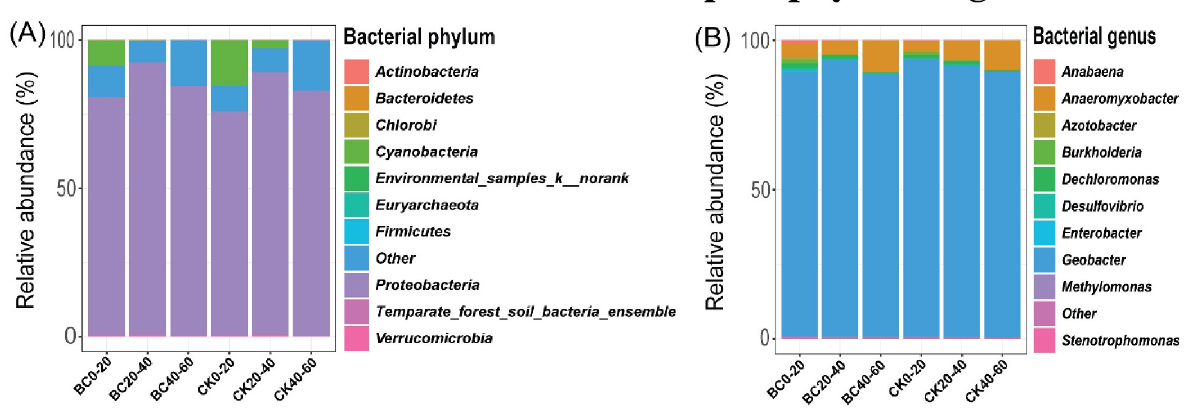
Fig 4. Diazotrophic bacterial relative abundance. (A) diazotrophic phyla, (B) diazotrophic genera under and biochar amended soil and control in different soil depths. “Other” indicates those identified phyla and genera that were beyond the top 10 phyla and genera.